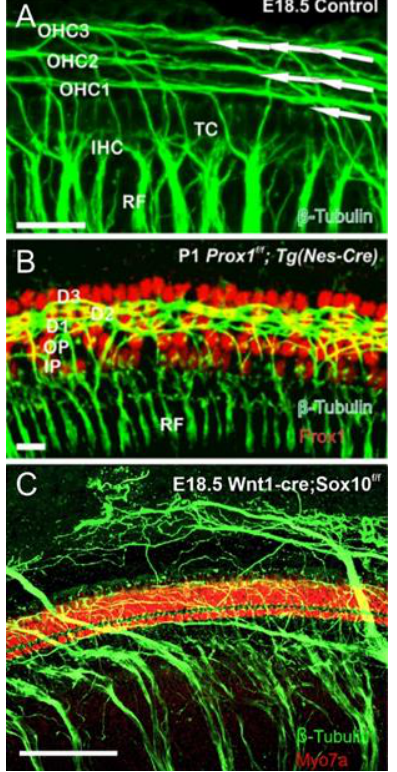
Figure 3. Cochlear fibers segregate by various patterns of innervation. The two types of the organ of Corti (OC) hair cells (inner hair cells, IHCs; outer hair cells, OHCs) are innervated by two types of spiral ganglion neurons ( A ). The innervation pattern shows changes in two mutations ( B , C ). The spiral ganglion neurons project as radial fibers (RF) to reach the hair cells in the OC. The normal innervation pattern shows a highly regular set of type I spiral ganglion neurons projecting to IHCs and type II spiral ganglion neurons, crossing the tunnel of Corti (TC) and projecting to the three rows of OHCs ( A ). Targeted deletion of Prox1 using Nestin-cre (Nes-Cre) results in all tunnel crossing fibers’ aggregation between the outer pillar cells (OP; B ). A more disruptive innervation pattern occurs with the lack of Schwann cells, as seen in Wnt1-cre; Sox10 f/f mice ( C ) Radial fibers completely bypass the OC (Myo7a-positive) hair cells and expand to the lateral wall. Bars 20 μm ( A , B ), 100 μm ( C ). Modified after [30,46,57].